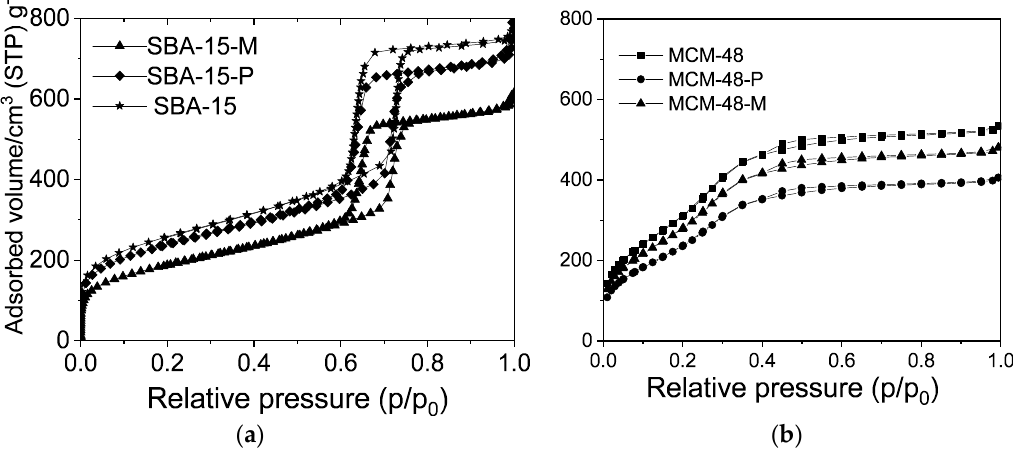
Figure 1. XRD of the initial and the modified SBA-15 ( a ) and MCM-48 ( b ) materials. Nitrogen adsorption and desorption isotherms of the parent and amino-modified SBA-15 and MCM-48 samples are presented in Figure 2.